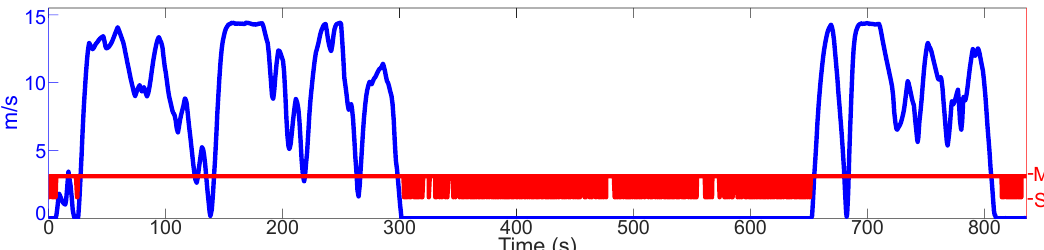
Figure 7. Shown is the RF output (red, S = standstill, M = motion) and the velocity over ground of the vehicle (blue). Vehicle: 5th Gen. Audi A4. Motorization: 6 cylinder, 3.0 L TDI. Power source: Diesel.